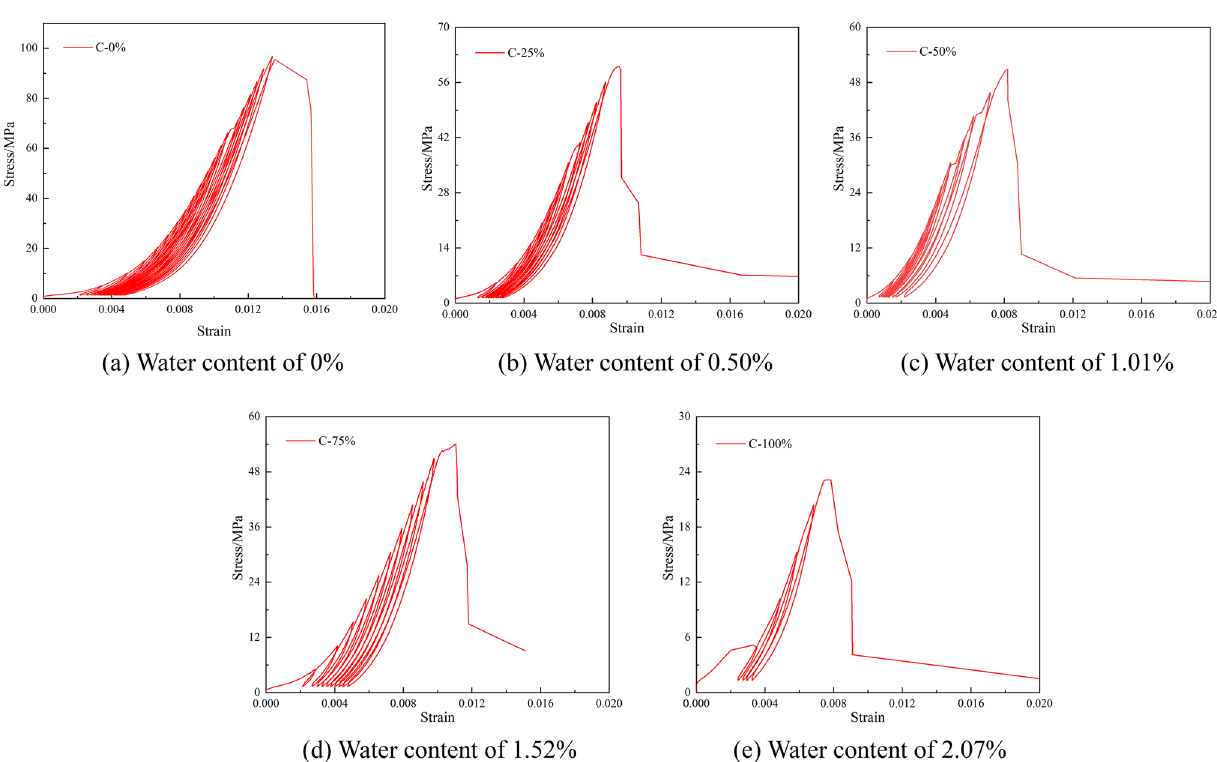
Fig. 8 Cyclic stress–strain